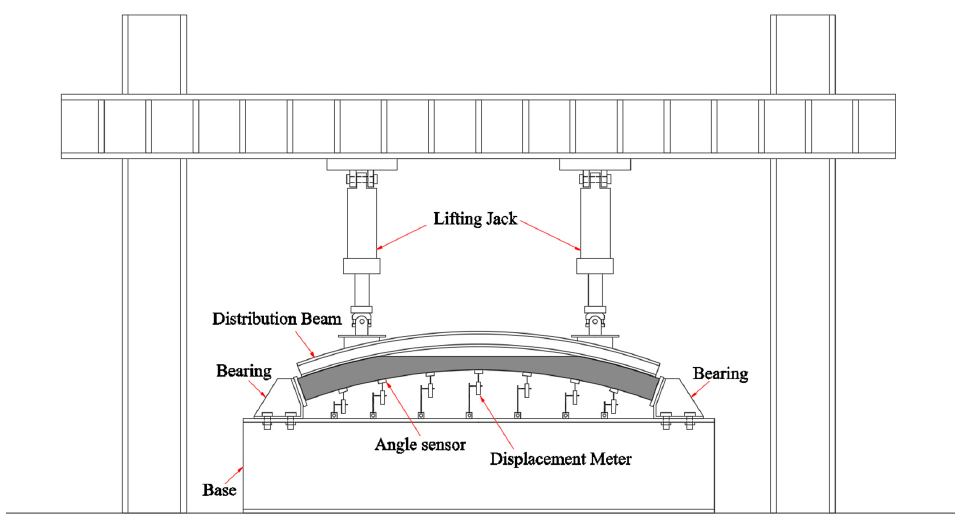
Figure 5. Layout of the loading system.